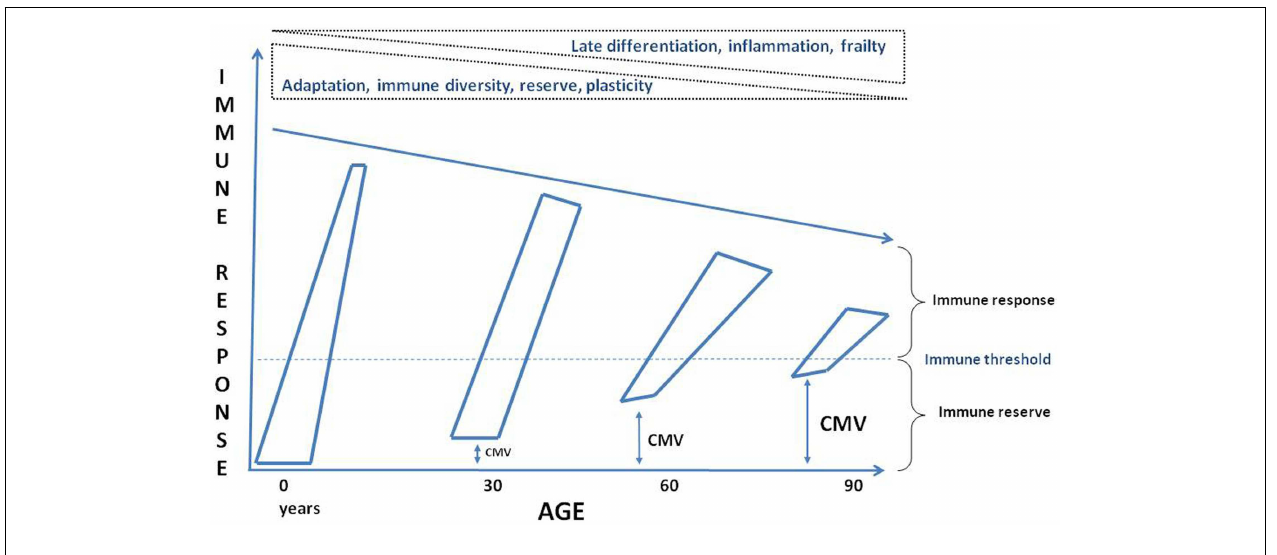
and maintained due to a complete reshaping of the immune cells by the immune history, such as persistent viral infection, putatively CMV. ↔ : Represents possible CMV infection effects on the immune reserve and the